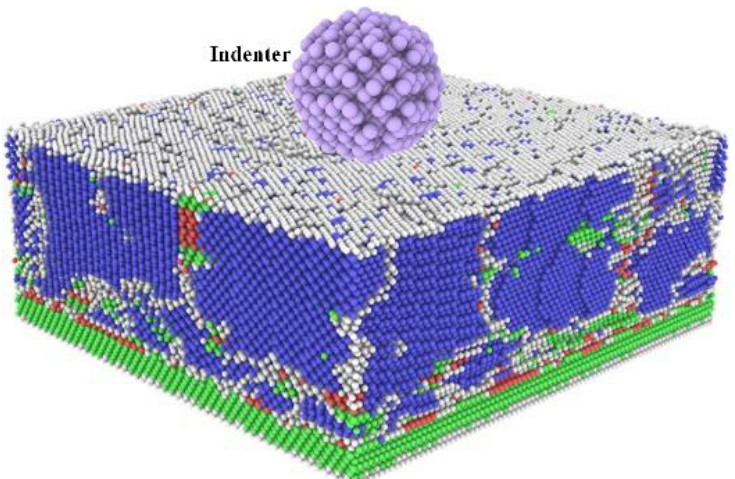
Figure 3. Physical model of nanoindentation. The top purple sphere represents the virtual indenter. The bottom block is output model of sputter deposition, which color coding with common neighbor analysis (CNA) (Reproduced with permission from [47]. Journal of Physical Chemistry, 1987). The green and blue atoms represent FCC and BCC structure type,